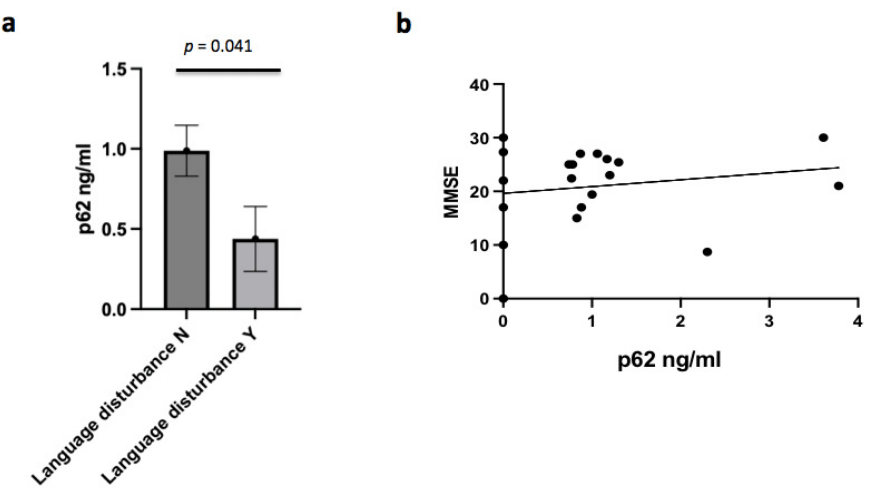
Figure 4. ( a ) Relationship between p62 concentrations and language disturbance ( p = 0.041). ( b ) Cor- relation between p62 concentrations and MMSE score in AD patients